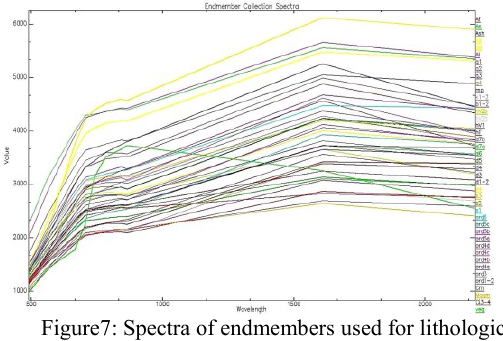
Figure7: Spectra of endmembers used for lithological classification in the study area